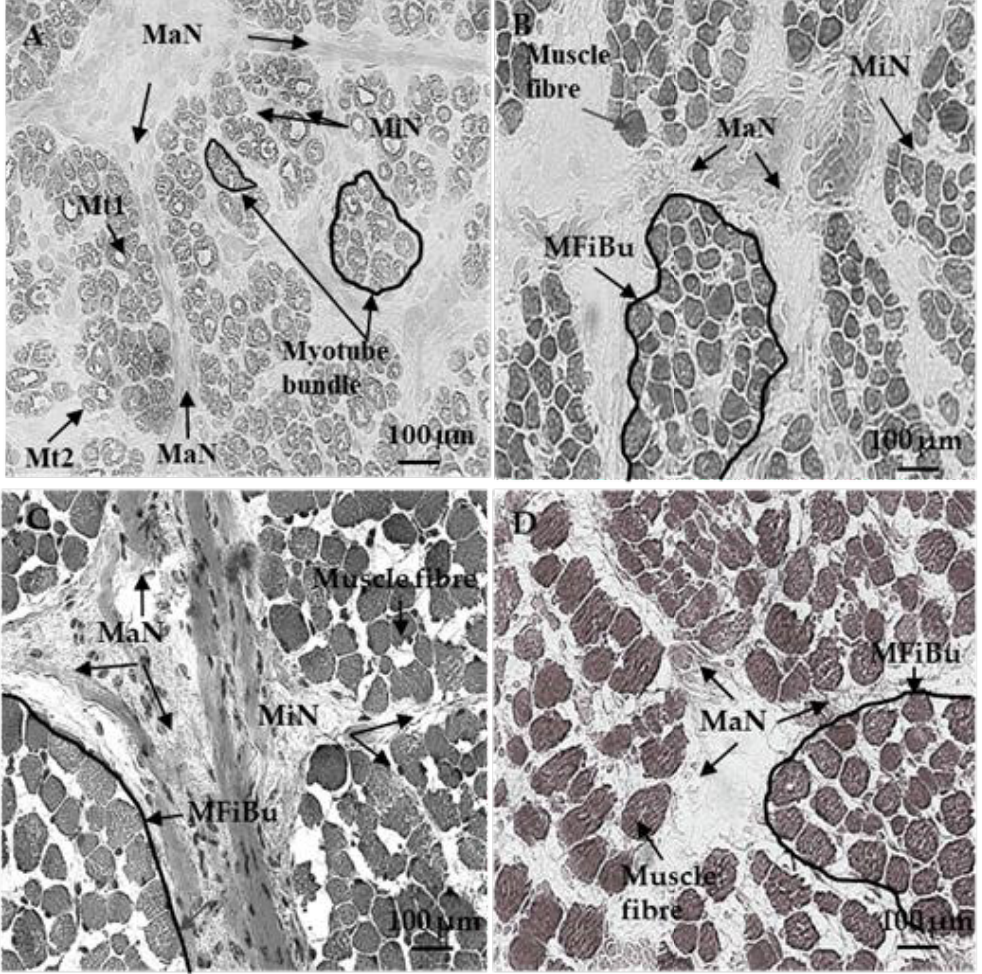
Figure 1. Azorubine staining of transverse sections of foetal Semitendinosus muscle at 110 ( A ), 180 ( B ), 210 ( C ) and 260 ( D ) days post-conception (dpc). (ECM: ExtraCellular Matrix; MaN: perimysium